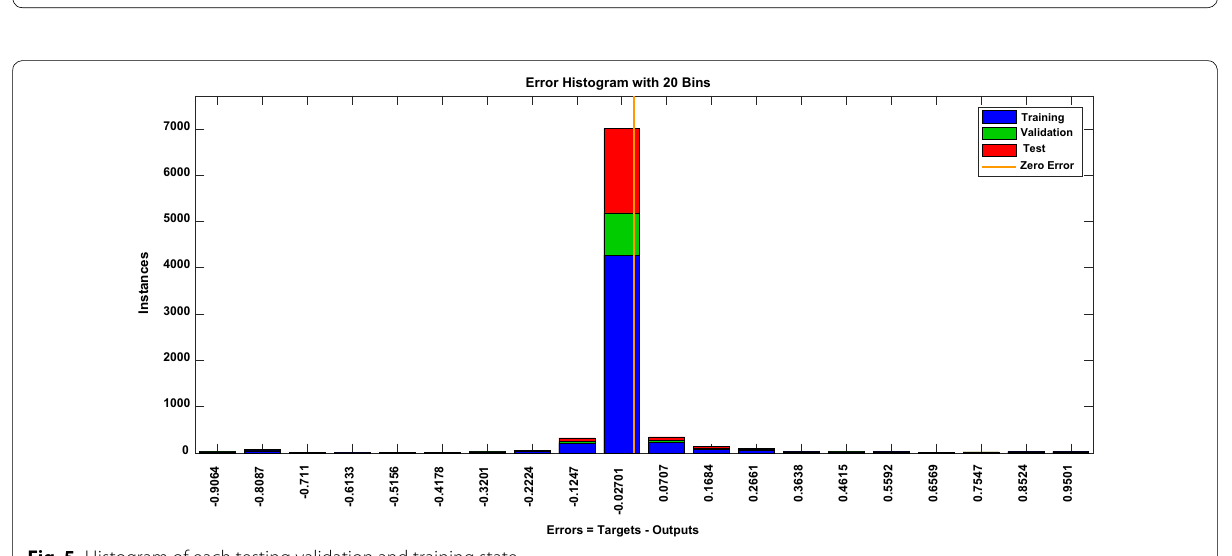
Fig. 4 Showing best validation performance at epoch 60